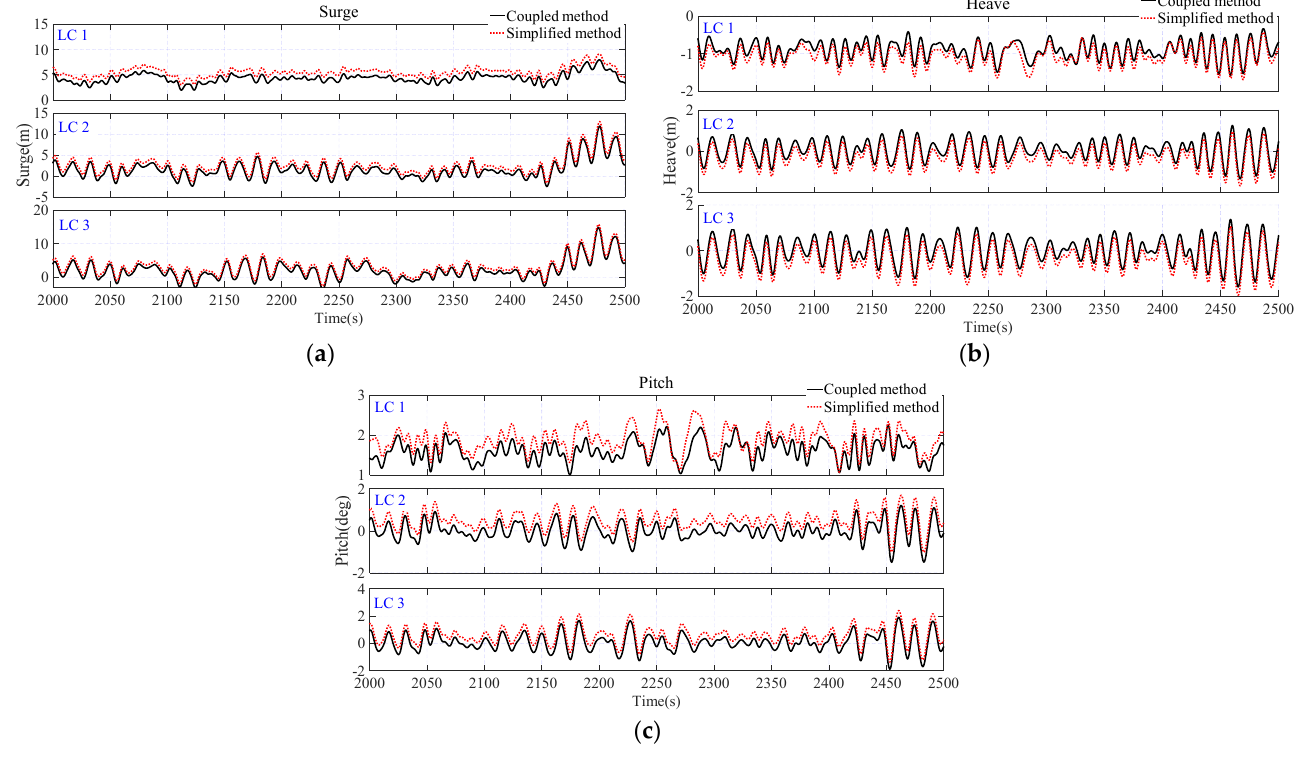
Figure 10. Time series of the WindFloat SFOWT motion in: ( a ) Surge; ( b ) Heave; ( c ) Pitch.